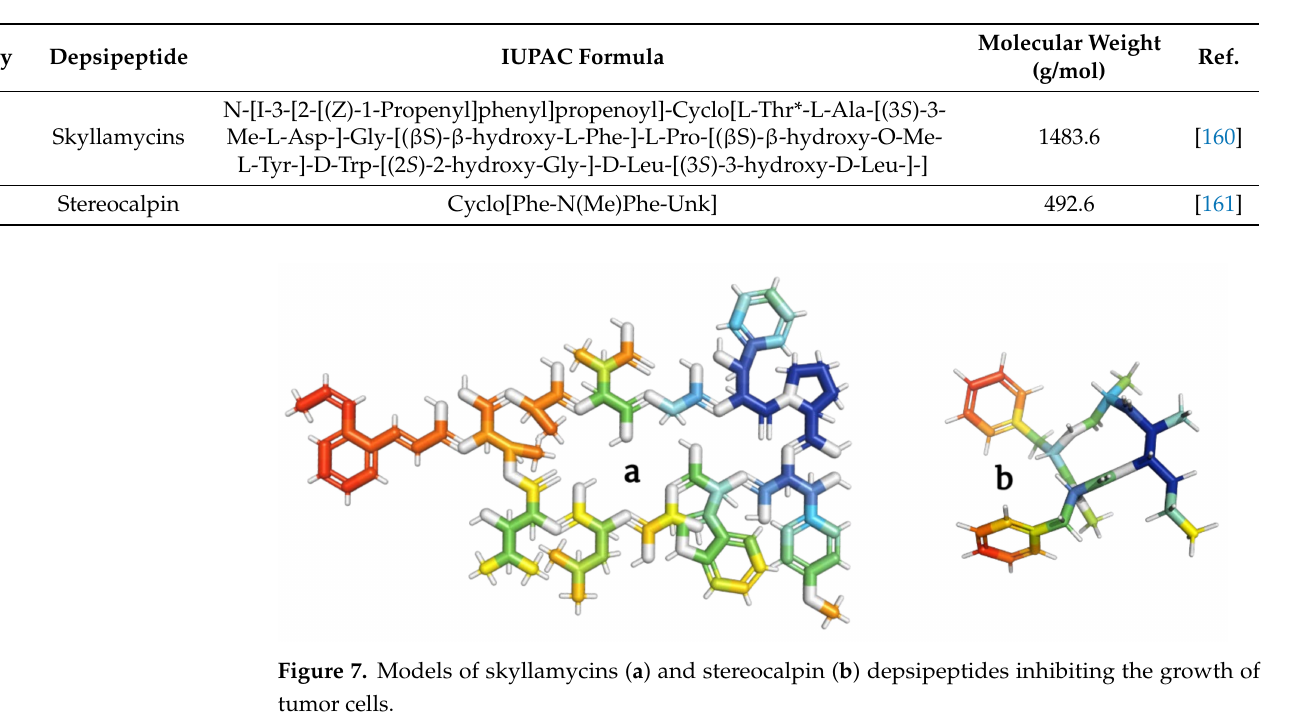
Table 6. Formula and molecular weight of depsipeptides inhibiting the growth of tumor cells.